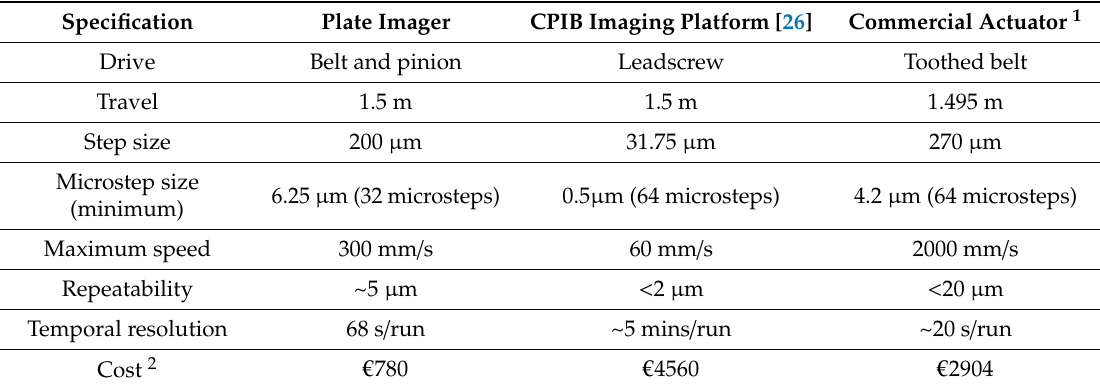
Table 3. Comparison of Plate Imager specifications with competing (research and commercial)